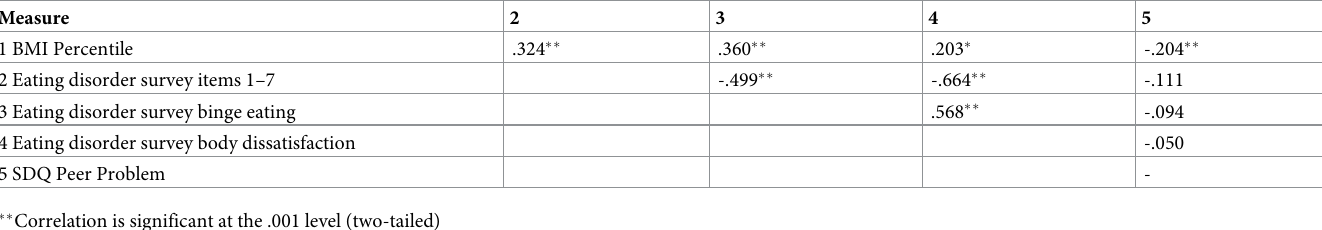
Table 8. Pearson’s correlations for control group BMI percentile.